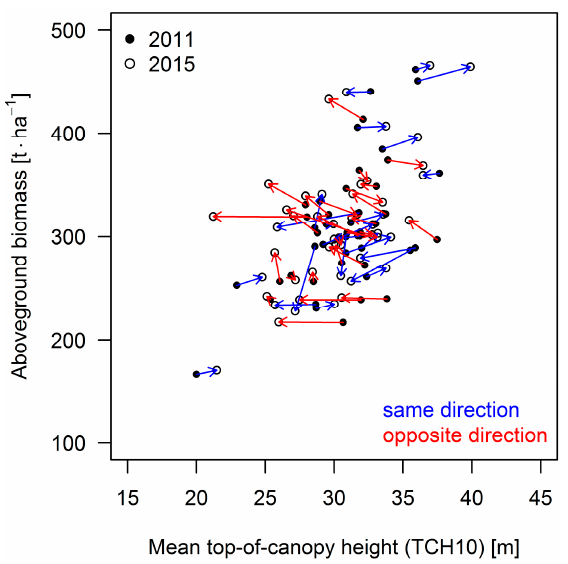
Figure 9. Aboveground biomass (AGB) plotted over canopy height (TCH10) for the two different years. Each point represents 1 ha of the BCI 50 ha plot. Arrows represent the change in both attributes over the 4-year interval. Colors of the arrows indicate whether AGB and TCH10 changed in the same ( blue ) or opposite ( red ) direction.